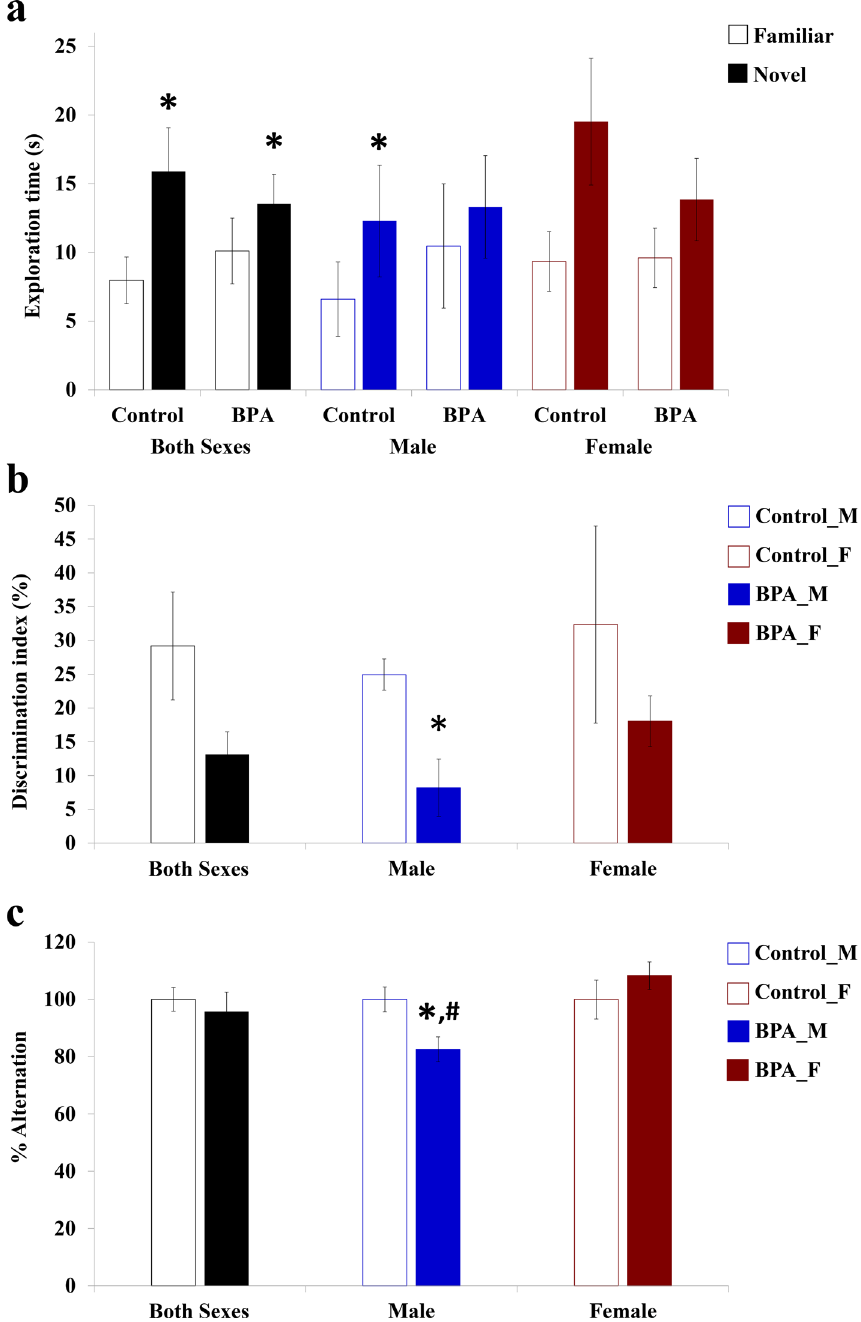
Figure 7. Prenatal exposure to BPA reduces learning and memory functions evaluated by the NOR test and T-maze spontaneous alternation test. The learning and memory functions in the offspring were assessed using NOR and T-maze tests. In the NOR test, the times that the rat spent exploring a familiar object and exploring a novel object were measured ( a ) and used for calculating the discrimination index ( b ). In the T-maze test, the number of turns in each goal arm was recorded, and the percentage of alternation was calculated ( c ). Data are presented as the mean ± SEM. * ,# P value < 0.05. *Indicates a statistically significant difference between the BPA treatment and the vehicle control groups. # Indicates a statistically significant difference between males and females in the BPA